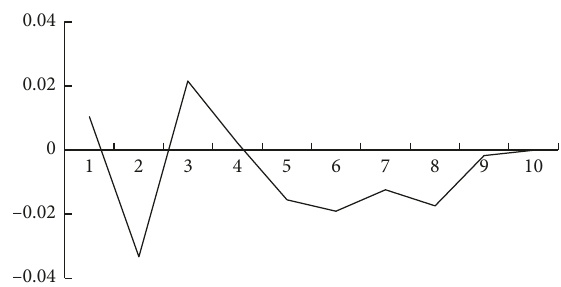
Figure 7: Grey cospectrum of AQI and housing price.